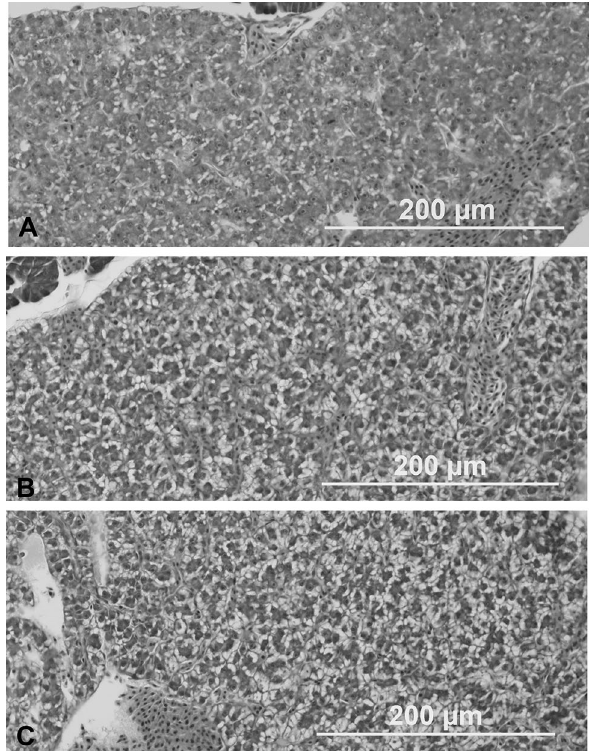
Figure 4. Liver of juvenile carp ( Cyprinus carpio L.) after 35 days praziquantel exposure. Haematoxylin and eosin, × 200. ( A ) Control group; ( B ) control ethanol group (ethanol 0.8 ml/L); ( C ) Experimental group P1 (praziquantel 1.0 mg/L dissolved in ethanol). See the extensive steatosis (abnormal lipids retention) consisting of steatotic droplets of varying sizes in pictures ( B ) and ( C